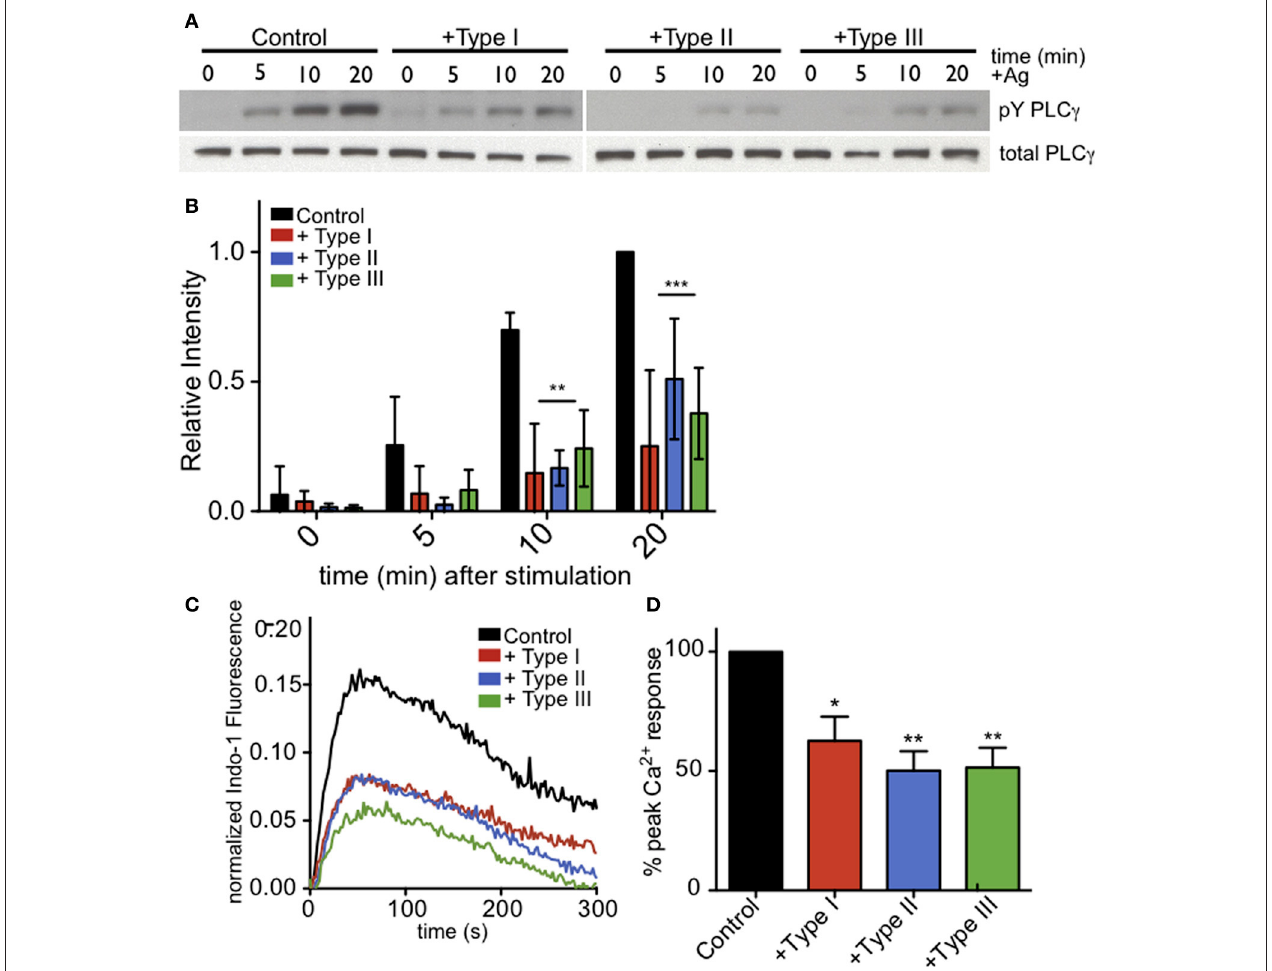
fluorescence measurements of Ca 2 + responses to 10ng/ml DNP-BSA in the absence of extracellular Ca 2 + in control uninfected (black), Type I-infected (red), Type II-infected (blue) or Type III-infected (green) cells (MOI 10:1). (D) Peak Ca 2 + responses in infected cells as a percentage of control Ca 2 + response of uninfected cells in the absence of extracellular Ca 2 + . Histogram shows averages of 3 independent experiments. Error bars represent SEM ( ∗ P < 0 . 05 and ∗∗ P < 0 . 01 relative to control